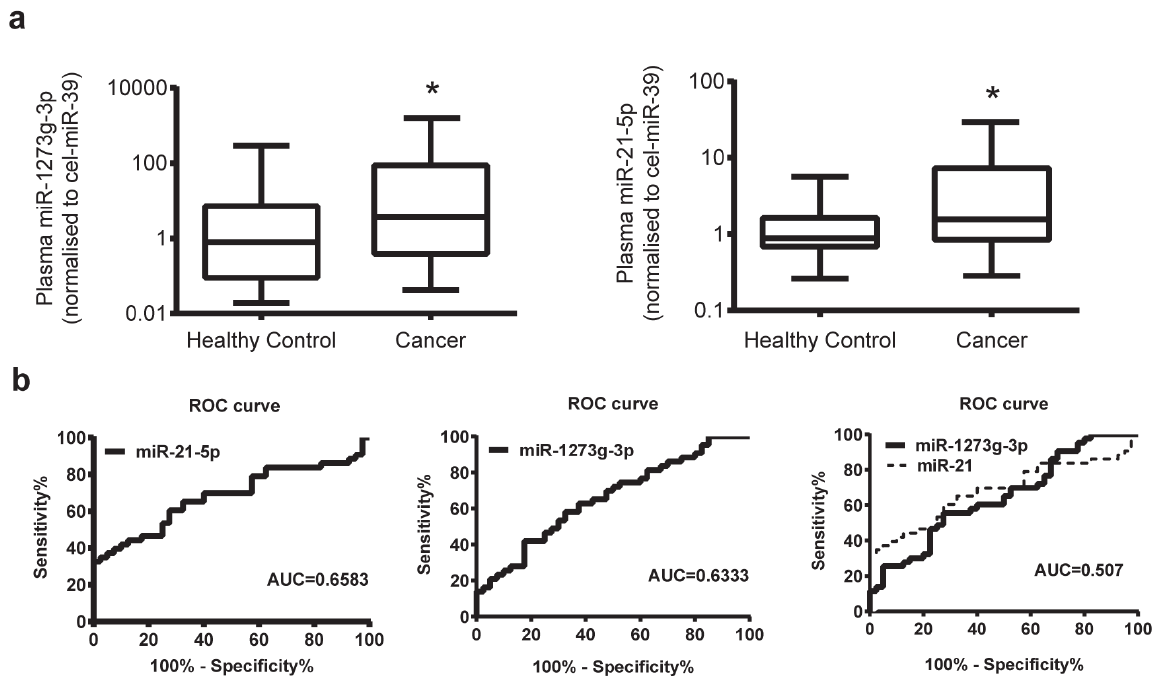
Figure 1. Validation of miRNAs in breast ductal cancer and healthy controls (n = 79). (a) Box plot of plasma levels of miR-21-5p and miR-1273g-3p in breast cancer ductal patients. The expression of miRNAs was normalised to cel-miR-39. The lines inside the boxes represent the medians. The boxes mark the interval between the 25th and 75th percentiles. The whiskers denote the interval between the 10th and 90th percentiles. Statistically significant differences were determined using Mann–Whitney tests. (b) Receiver-operator characteristics (ROC) curve analysis of miRNAs to discriminate BC patients from healthy controls. *p